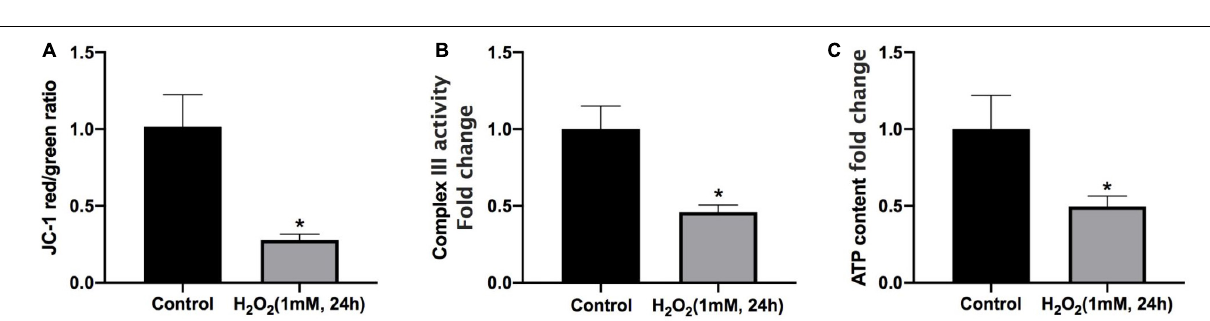
FIGURE 3 | Effects of H 2 O 2 on mitophagy in NP cells. (A,B) The protein level of P62, LC3-I, and LC3-II in the NP cells was measured by Western blotting. (C) Immunofluorescence of the P62 protein in NP cells (Green signal represents P62, blue signal represents DAPI). * p < 0.05 vs. control group.